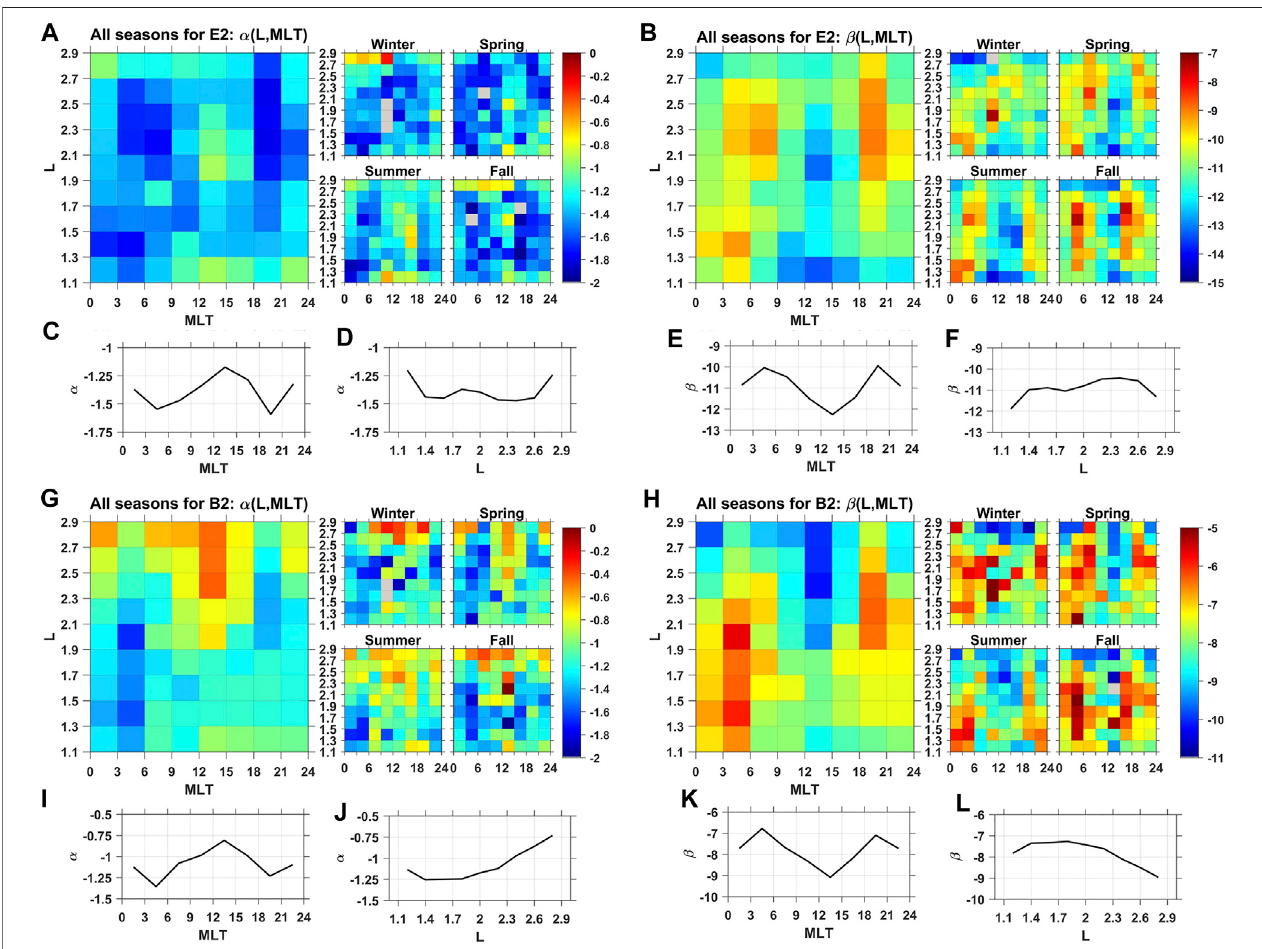
FIGURE3|(A – F) Electricand (G-I) magneticattenuationlawparameters (A,G) α and (B,H) β parametersoftheattenuationlawsfor (A,B) (E 2 /W) (D) and (G,H) (B 2 / W) (D) attenuationlaws.Unidimentionalplotsshowtheaveragewithrespectto (C,E,I,K) L-shelland (D,F,J,L) MLTofthe (C,D,I,J) α and (E,F,K,L) β parameters. Decay ofE 2 /Wfollowsmoreaquadriclaw,with ∼ − 2 < α < ∼ − 1(bluetogreenina).DecayofB 2 /Wfollowsmorealinearlaw,with ∼ − 1 < α < ∼ 0(greentoreding).Day/nightdifference is well-marked. The α and β parameters behave oppositely in MLT as shown in C,E,I,K .